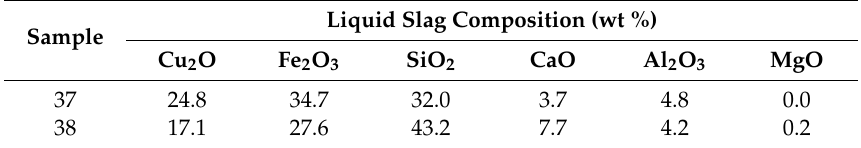
Table 5. Liquid slag compositions (wt %) of industrial tests at temperature between 1230 °C and 1250 °C.